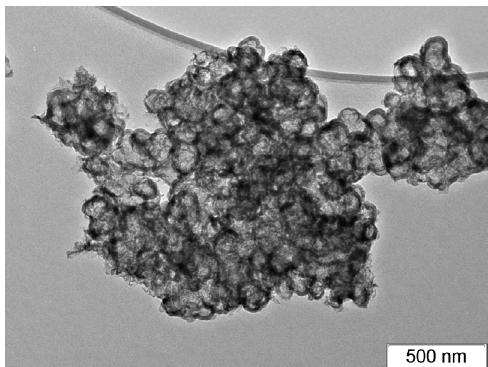
Figure 1. TEM image of the Sibunit support.